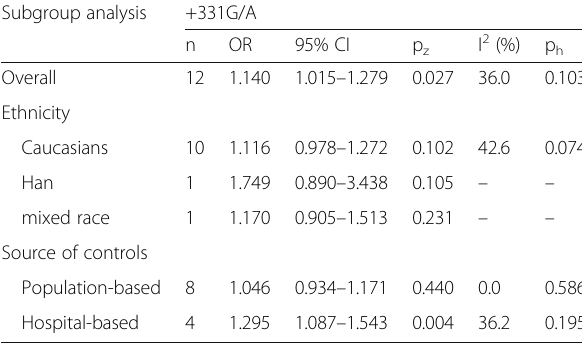
Table 4 Stratified analysis of the association of PGR polymorphism with breast cancer under dominant model Subgroup